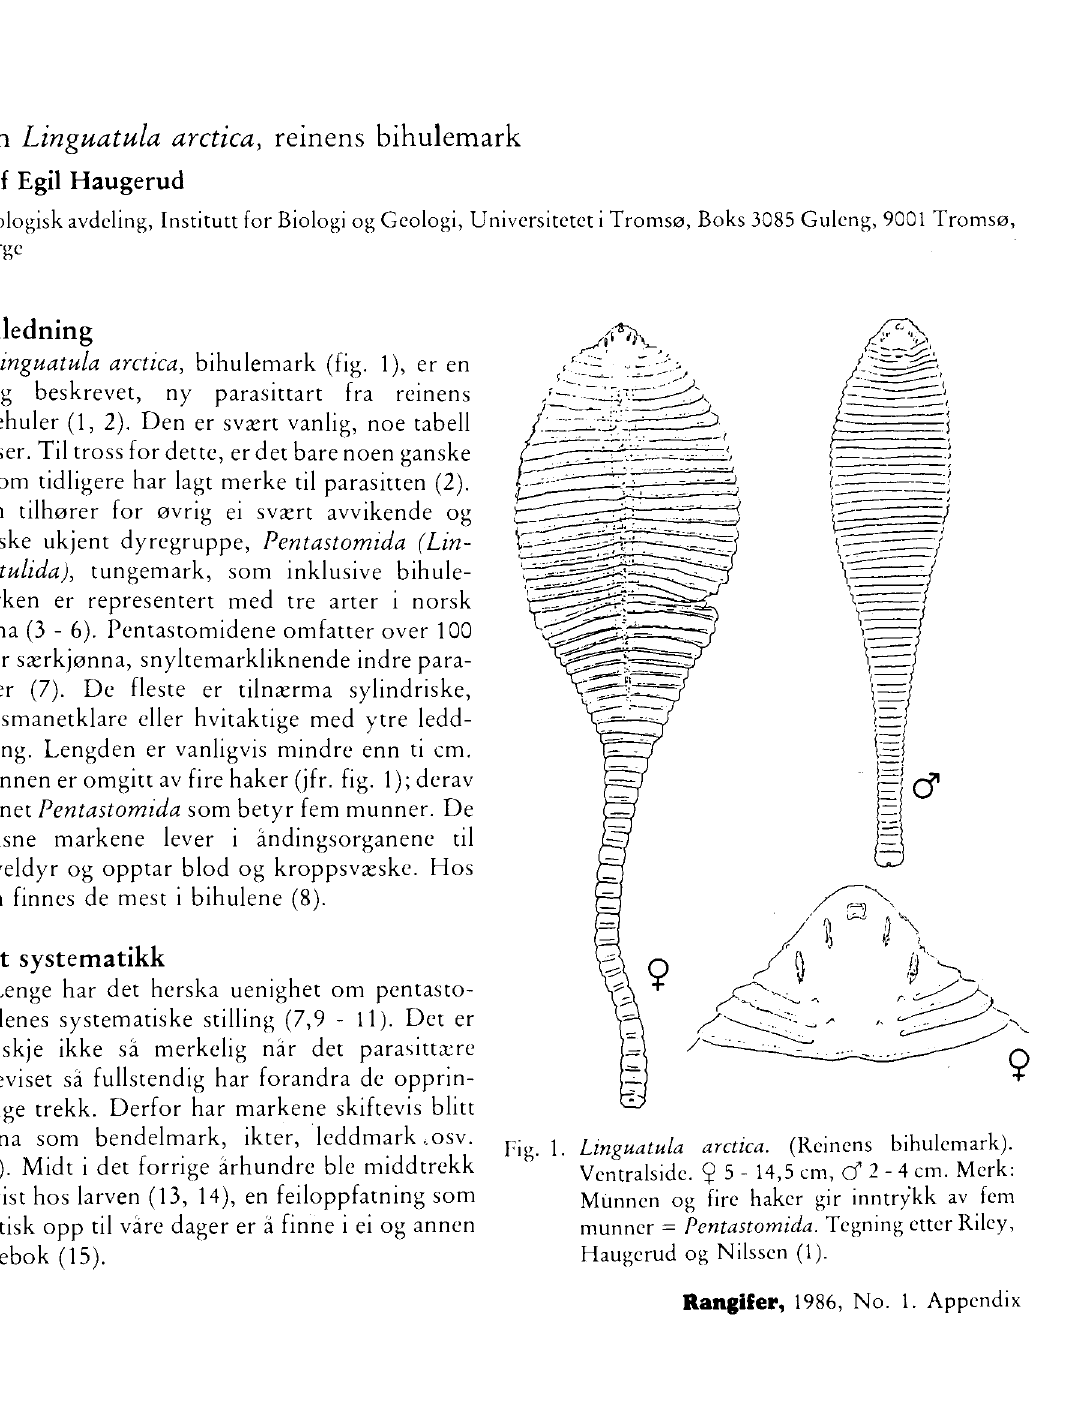
Fig. 1. Linguatula arctica. (Reinens